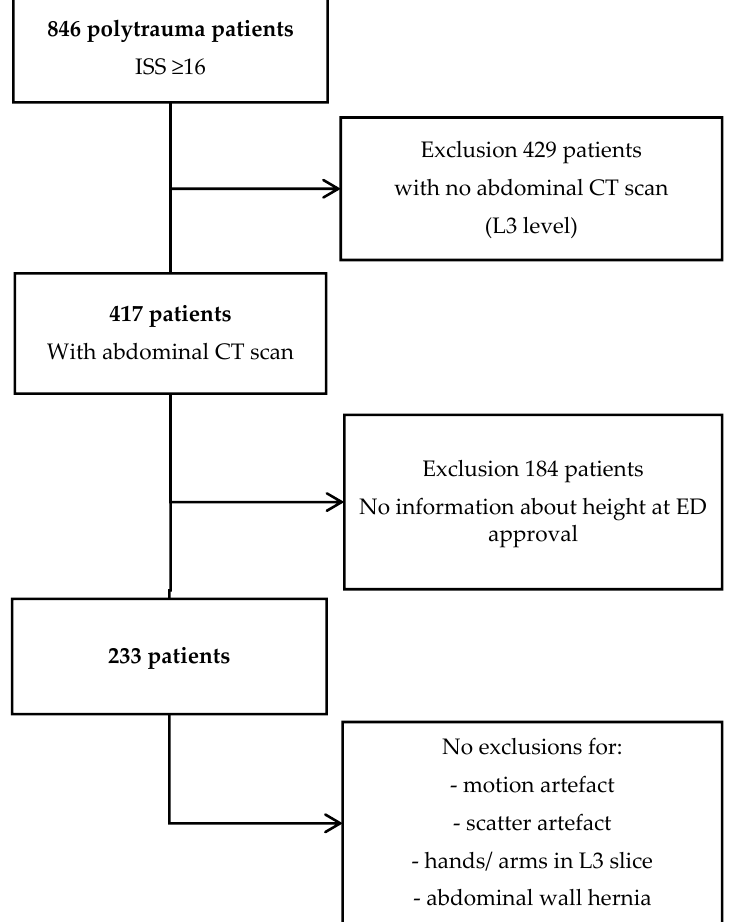
Figure 1. Flowchart of test case attrition numbers from a trauma case registry. ISS = Injury Severity Score.